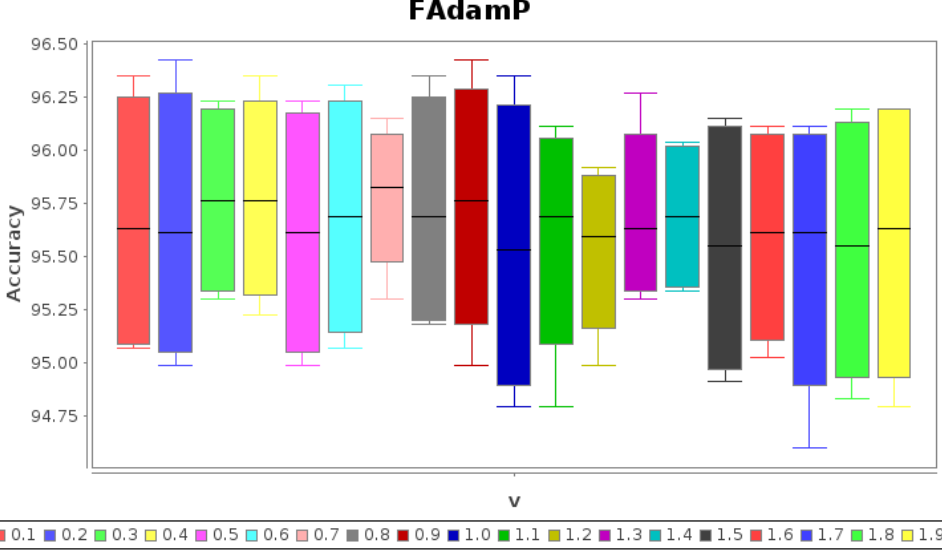
Figure 17. Experiment 3.2: FAdamP cross-folding accuracies, K = 4 folds, ν ∈ [ 0.1,1.9 ]